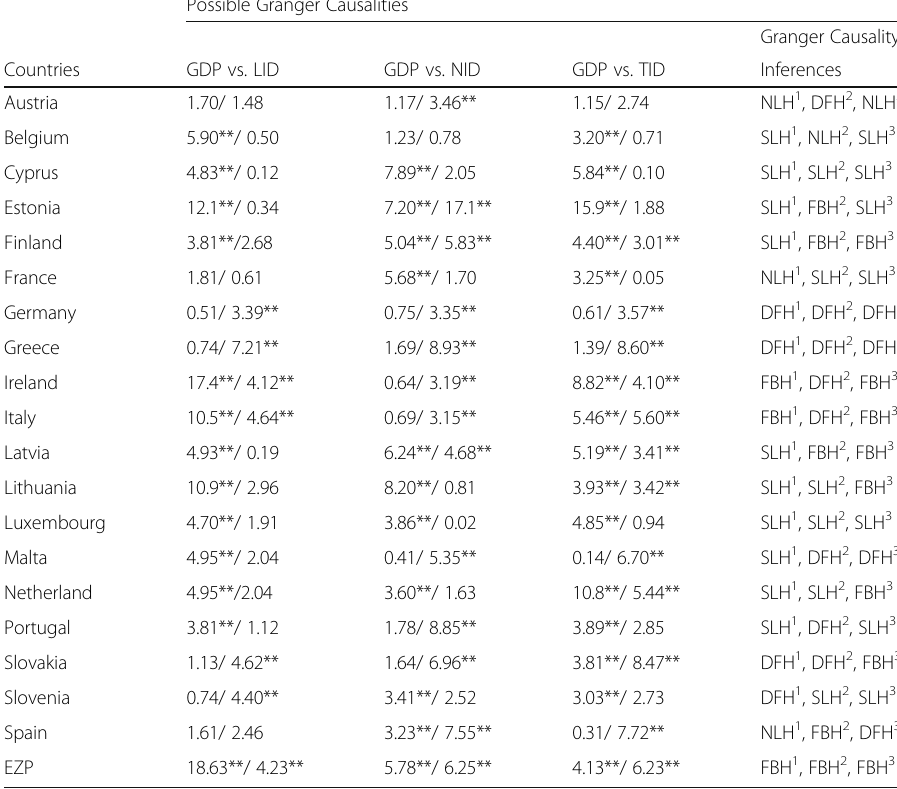
Granger Causality